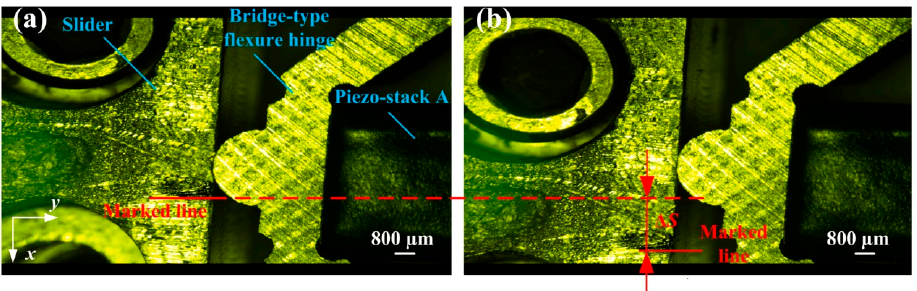
Figure 15. In situ observation of the stick-slip process: ( a ) initial position; and ( b ) ending position.